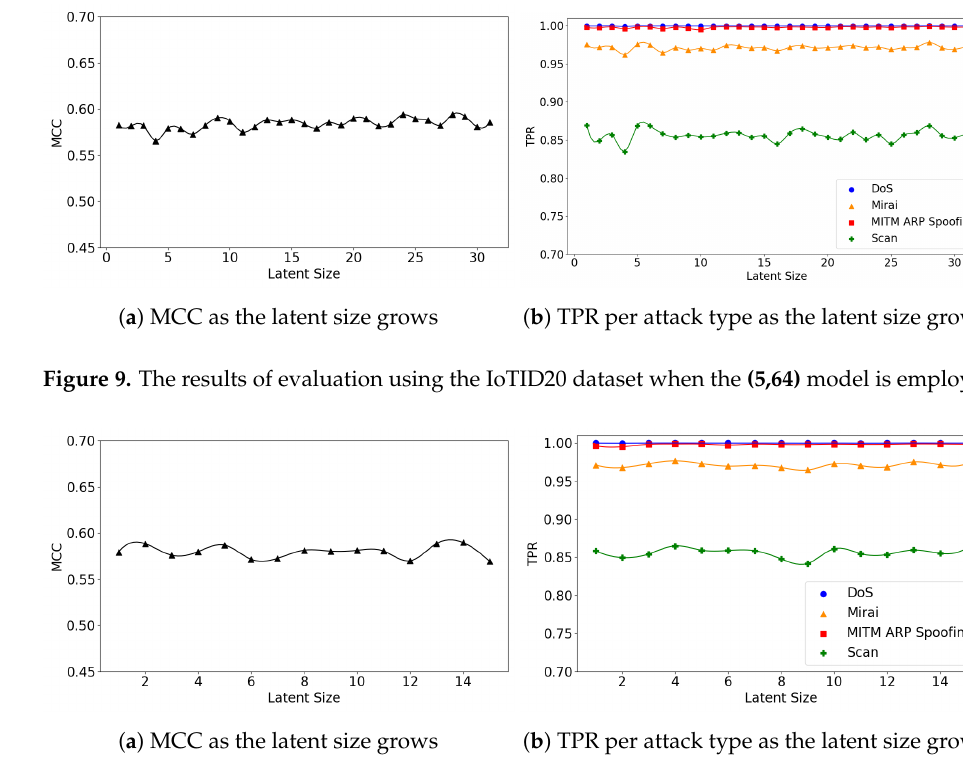
Figure 10. The results of evaluation using the IoTID20 dataset when the (7,64) model is employed. Figure 11 visualizes the reconstruction distance distributions of the normal and all the attack types with the (5,64) model for the latent sizes of 28 and 9, which produce the best and a near-best performance, respectively. Despite the significant difference in the latent size, the graphs in the figure show similar patterns; the normal samples are distributed between − 1 and 3, and the most attack samples are distributed between 1 and 4. This suggests that using a small latent size can characterize the data well and